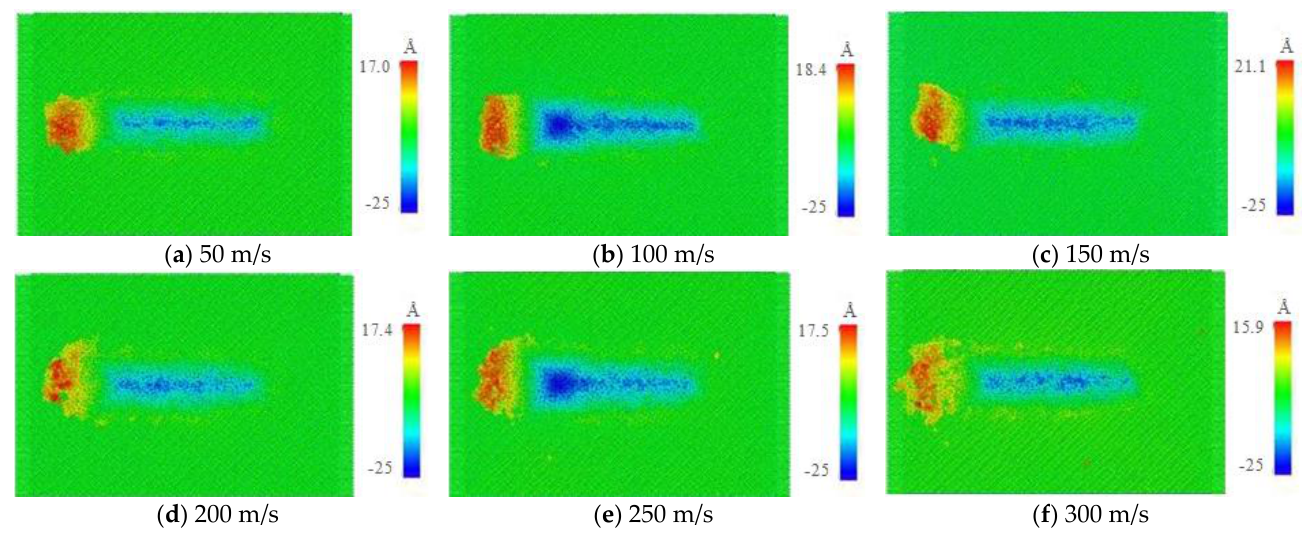
Figure 12. Scratch damage morphology with different scratch speeds.